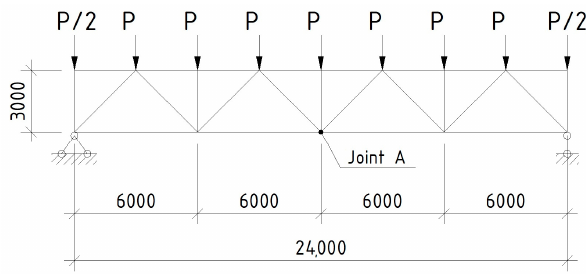
Figure 11. Spatial model of a large-span building. Structural scheme, var. No.1.